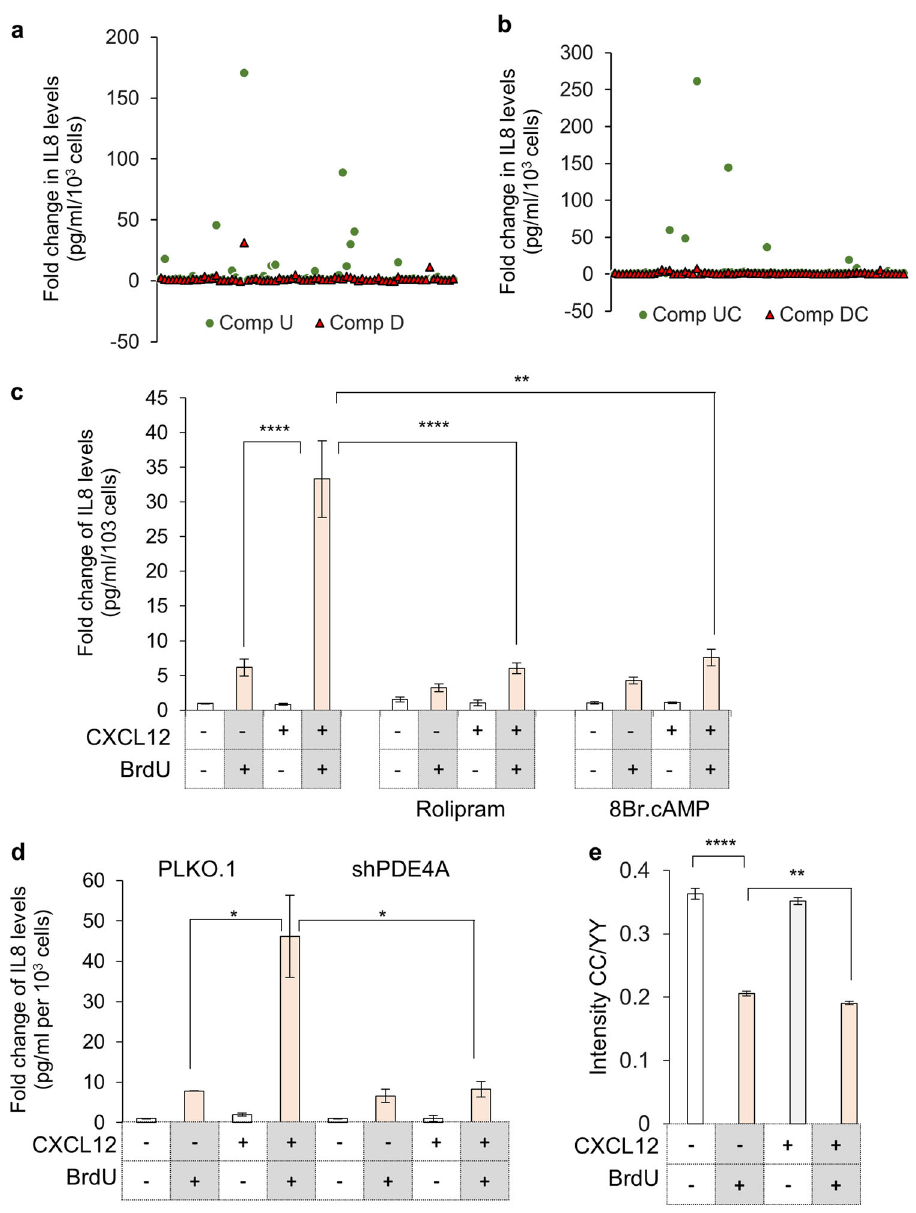
Fig. 5 Identi fi cation of signaling cascade involved in CXCR4-activation dependent enhanced in fl ammation during DNA damage. a Screening for compounds modulating DNA damage associated in fl ammation. Scatter plot for individual compounds in LOPAC plate 1 representing fold change of IL8 secretion (through ELISA) when compared to untreated (Comp U, circle) or damaged cells (Comp D, triangle). b Scatter plot of compounds modulating CXCR4 activation dependent enhanced DNA damage-associated in fl ammation. Scatter plot for individual compounds from LOPAC plate 1, representing fold change of IL8 levels (through ELISA) compared to CXCL12 stimulated cells which are untreated (Comp UC, circle) or in presence of DNA damage (Comp DC, triangle) is shown. c Role of cAMP modulators on CXCR4 dependent enhanced in fl ammatory response. The media from treated HeLa cells (as indicated) was used for determining IL8 levels compared to untreated control cells ( n = 3). d Effect of PDE4A expression knockdown on CXCR4 activation dependent in fl ammation. The media from treated and untreated HeLa cells transfected with shRNAs as indicated was used to determine levels of IL8 ( n = 4). e Measurement of cAMP levels in CXCL12 treated damaged cells. FRET ratios recorded by measuring CC/YY intensity changes in ICUE3 reporter in HeLa cells treated as indicated (Cell images are shown in Supplementary Figure S5d). For all experiments results are shown as mean ± s.e.m. * p ≤ 0.05; ** p ≤ 0.01; *** p ≤ 0.01; **** p ≤ 0.001 (Student ’ s t -test; n = BALB/c mice to probe if changes in DNA damage associated genes Suppression of CXCR4 expression induction or activation in vivo abrogates in fl ammation post DNA-damage are recorded. We observed induction in levels of p21 gene, a classical marker associated with aging; Cxcl15 (IL8) , an in fl amma- Tissue injury due to DNA damage is one of the primary cause of tory cytokine as well of Cxcr4 receptor in older mice (Fig. 6c), physiological malice during anti-cancer therapies 38 as well as suggesting that CXCR4 can serve as a marker for DNA damage at during chronological aging, where an increase in DNA damage both cellular and organismal level. Similar observations were with time has been recorded. 4,39 In this context, fi rst we compared made in 4 – 6 weeks old C57BL6 mice subjected to sub-lethal dose gene expression changes between 2-month and 18-month-old